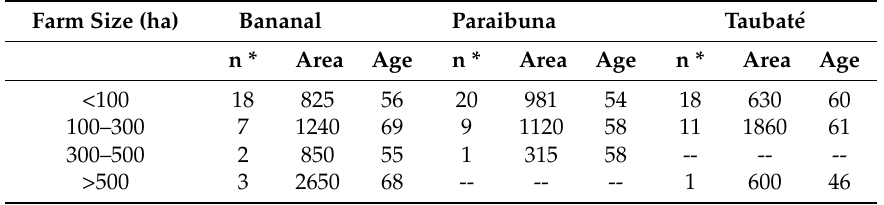
Table 4. Distribution of farm size classes (in hectares) per municipality and the farmer’s average age in each class. Farm Size (ha) Bananal